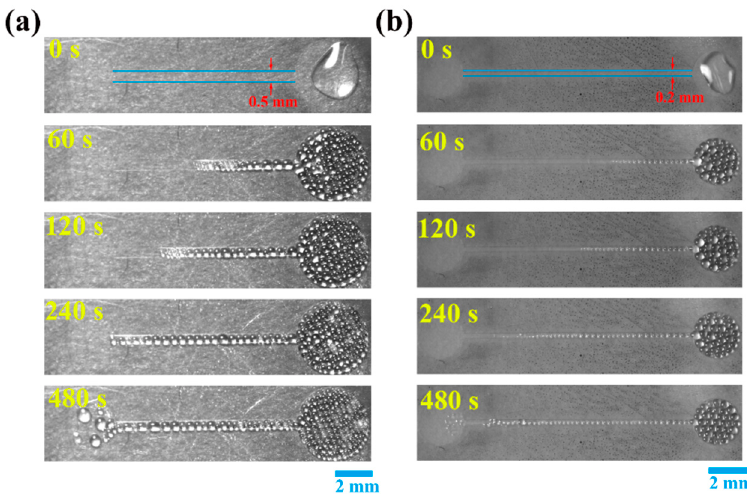
Figure 2. Dielectric droplets flow along microchannels under the action of corona discharge. ( a ) The channel width is 0.5 mm. ( b ) Similarly but with a channel width of 0.2 mm.